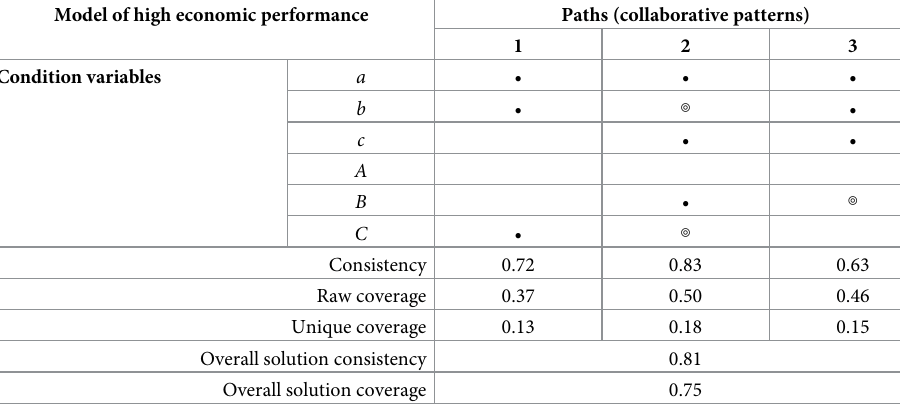
Table 5. The paths (collaborative patterns) to “high economic